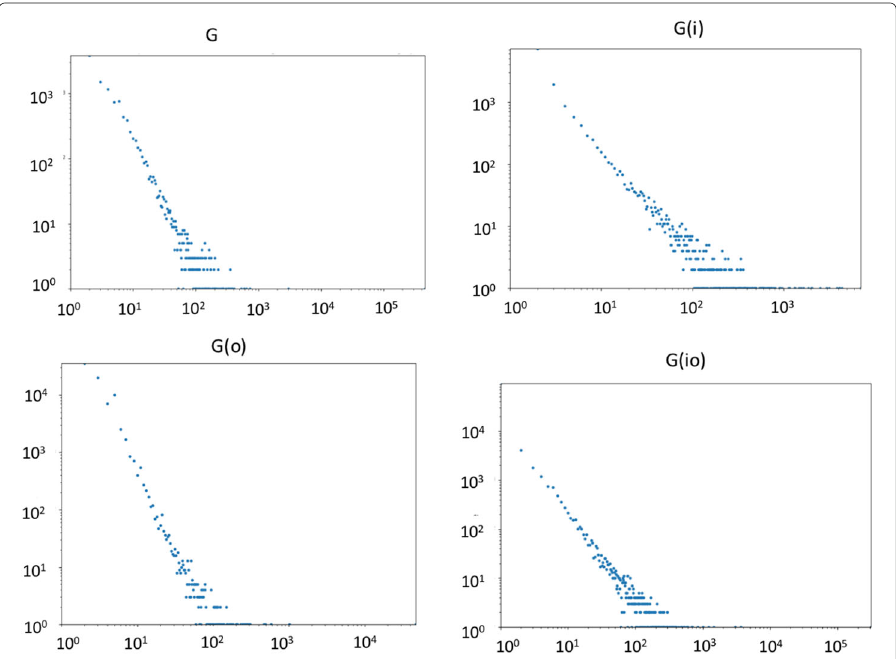
Fig. 6 Connected component size distributions of G , G i , G o , and G io . The x-axis is the number of nodes in a connected component and the y-axis is the frequency of that size in the